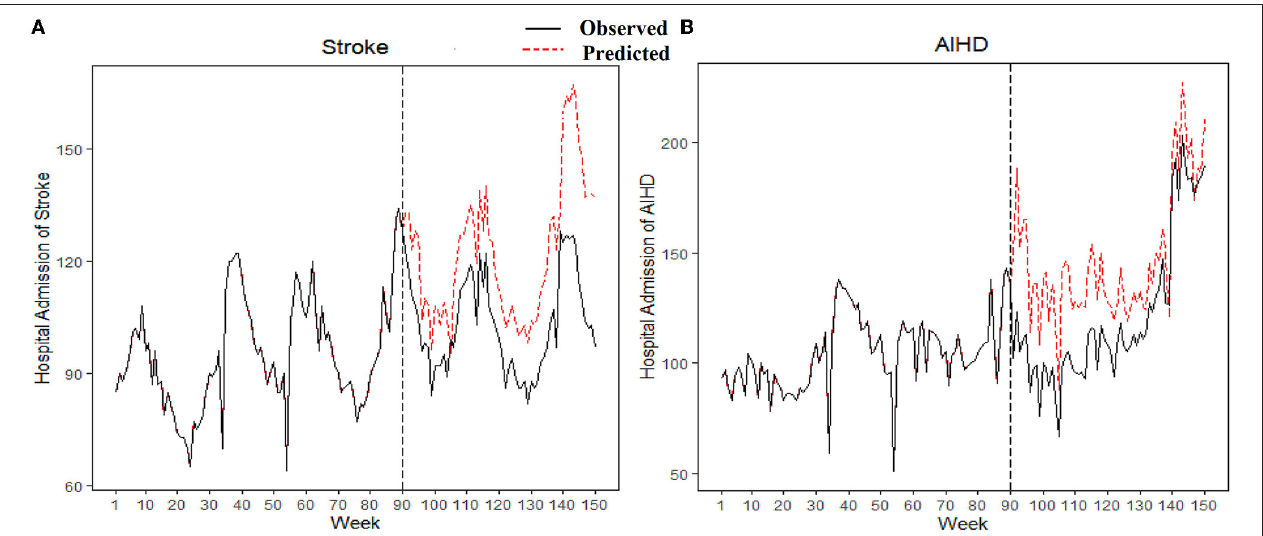
FIGURE 3 | The predicted and observed hospital admissions for stroke and AIHD from February 2017 to December 2019. The red line represents the predicted hospital admissions without the smoke-free policy according to the GAM model; the black line represents the observed hospital admissions. AIHD, acute ischemic heart disease; GAM, Generalized additive